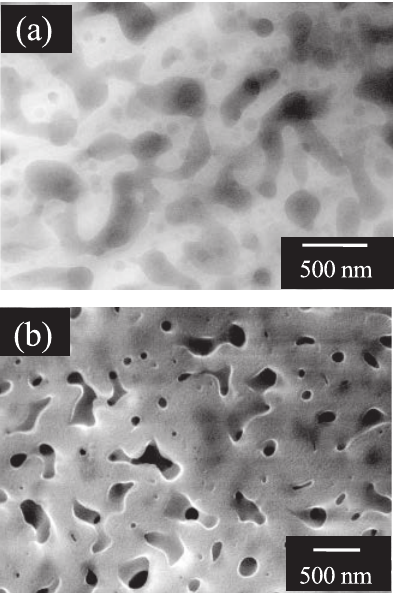
Fig. 7: Electron micrographs of glass G (65.0 SiO 2 -13.0 CaO-2.8 Al O -5.6 Na O-11.1 B O -2.5 mol% TiO 2 3 2 2 3 993 K for 96 h (b) after acid leaching with 1 M HCl solution